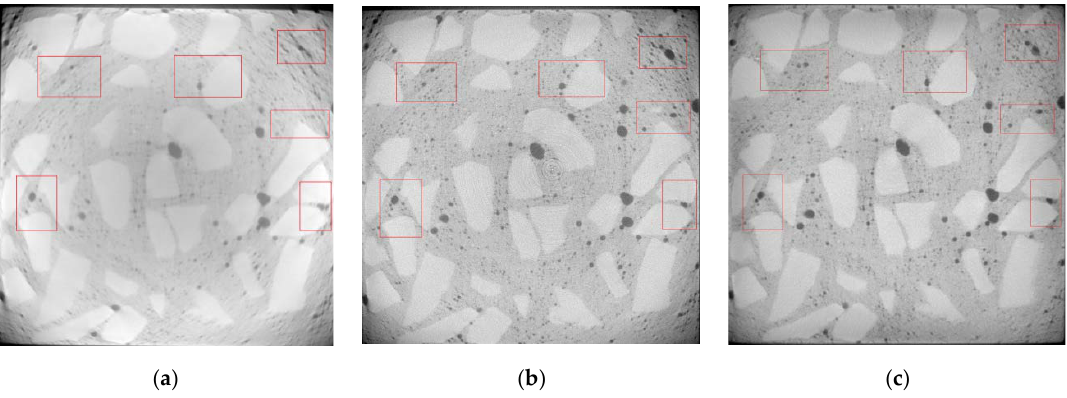
( b ) Figure 3. Proportion of pore numbers in concrete under dry and wet cycles of sulfate attack: ( a ) D5; ( b ) D4 . It can be seen from Figure 3 that the pores in concrete are unevenly distributed, and the number proportion of pores in the range of 0~0.05 mm 3 is significantly more than that of larger pores. As shown in Figure 3, with the increase of dry–wet cycles, the number proportion of pores in the range of 0~0.01 mm 3 increases first and then decreases, while the proportion of pores larger than 0.01 mm 3 shows a trend of decreasing first and then increasing. It is known that the sulfate solution permeates into the concrete through the pores on the surface and forms insoluble substances by the chemical reaction with hydration products [30]. With the larger surface area, the SO 4 2− in larger pores may react more fully with hydration products, and more erosion products will be generated in larger pores, which may promote larger pores evolving into small ones.